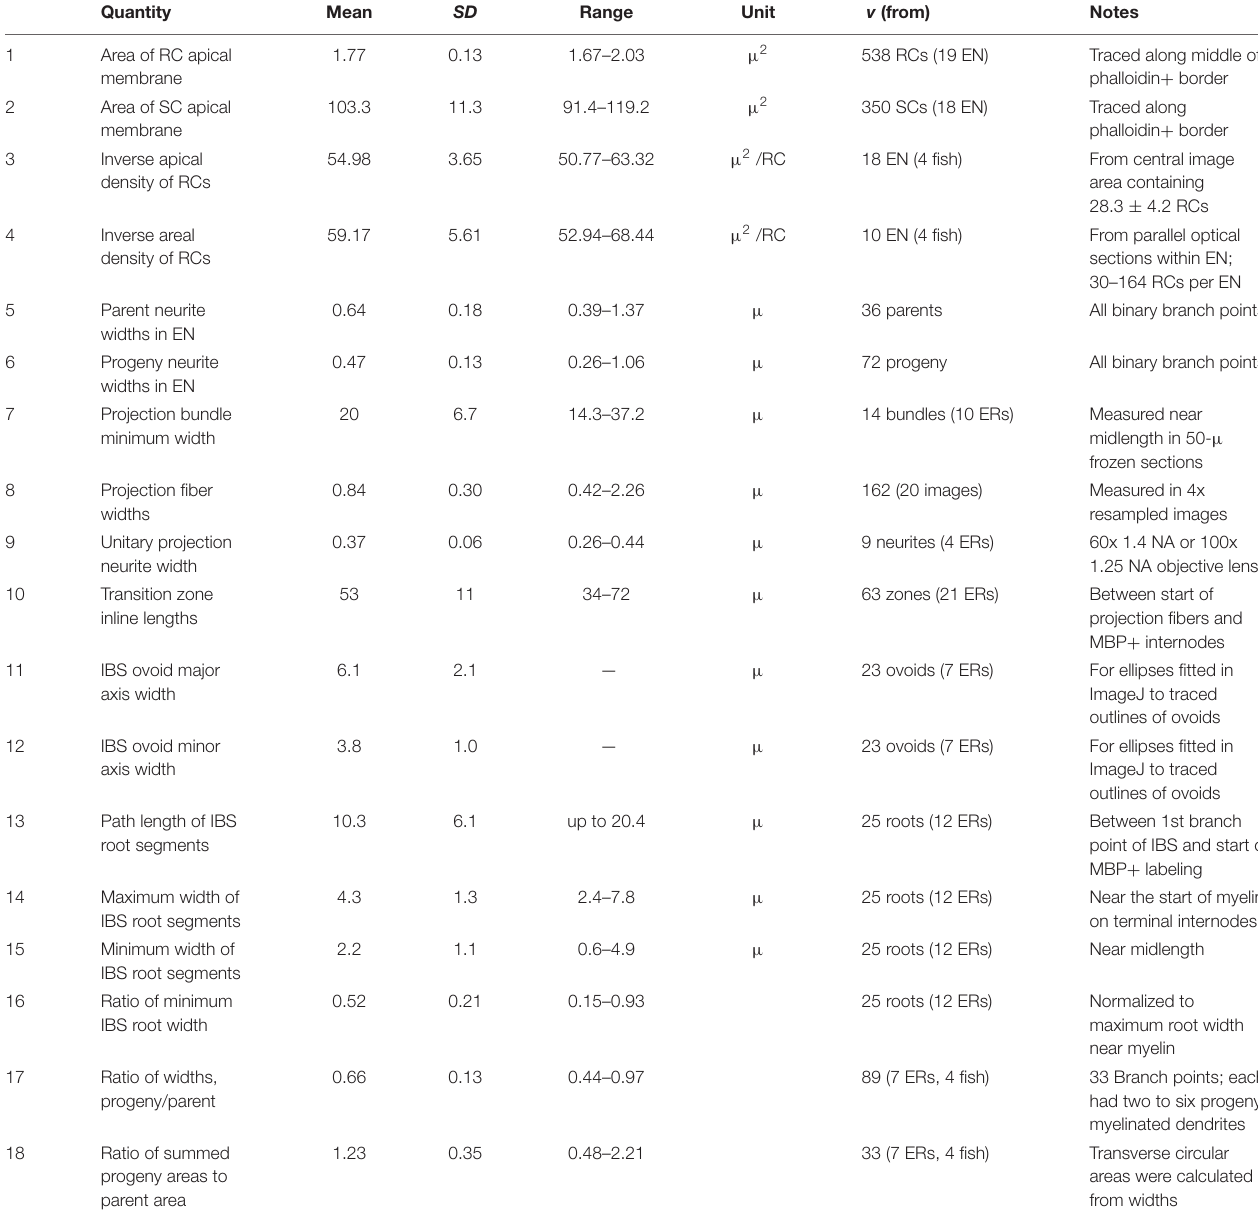
TABLE 2 | Measured values of Polyodon